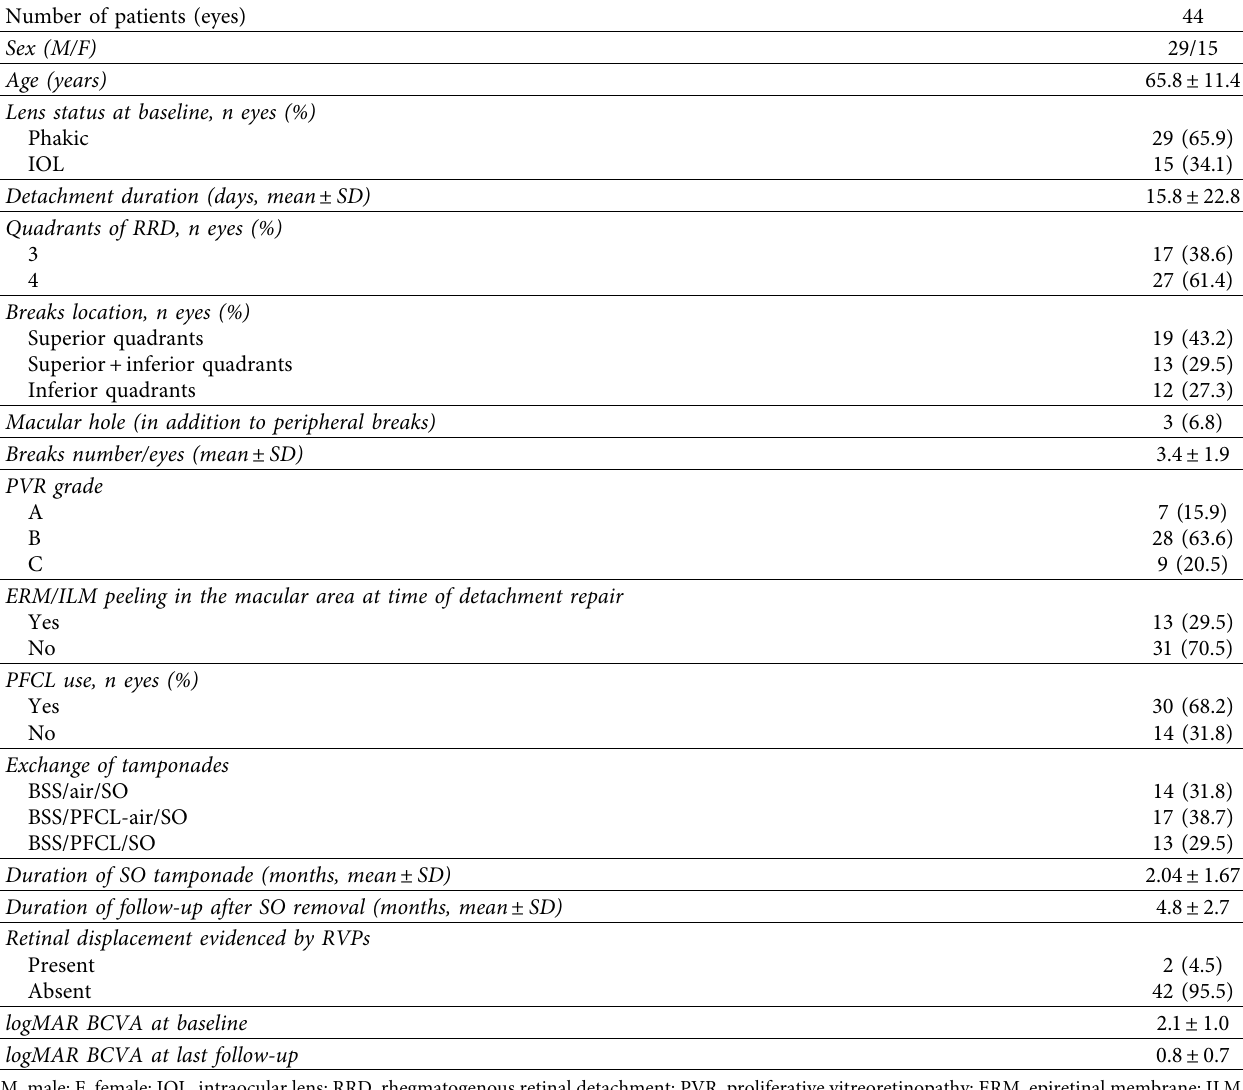
Table 1: Main pre-, intra-, and postoperative characteristics of the